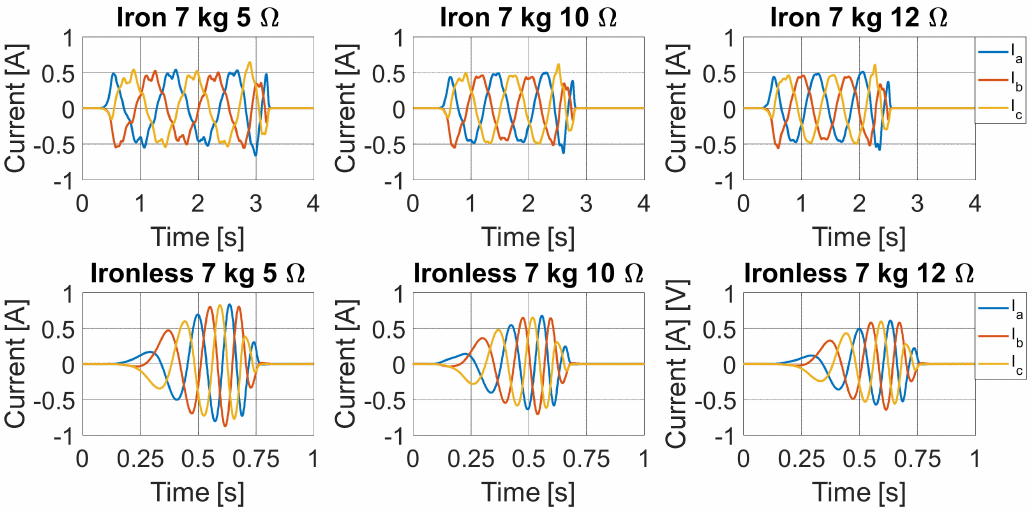
Figure 16. Load currents trends of the 7 kg test with a resistance load equal to 5 Ω , 10 Ω and 12 Ω .